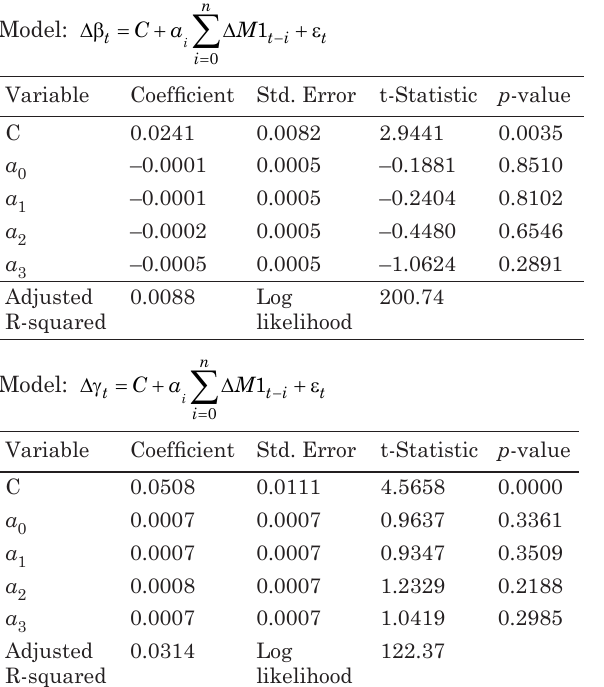
Table 7. Mean reversion, contemporaneous and